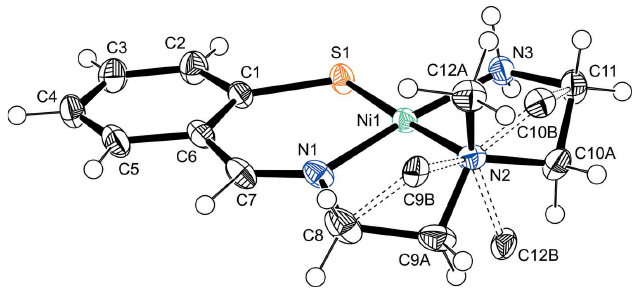
Figure 1 Perspective view of the complex cation of 1 with displacement ellipsoids at the 50% probability level. Hydrogen atoms of the minor occupancy component of the disordered region are omitted for